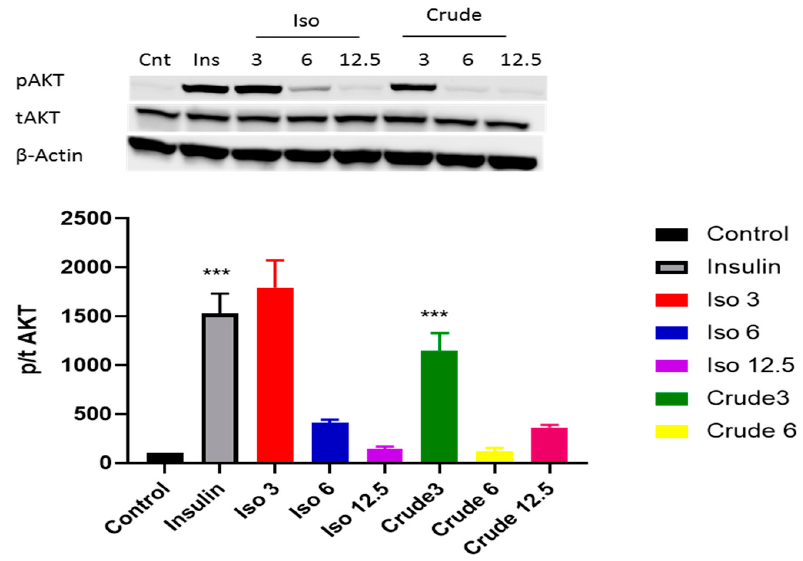
Figure 4. The effect of iso-mukaadial acetate and crude extract on protein kinase B (AKT) protein expression in L6 skeletal muscle cells. Results are expressed as mean ± SEM of three independent experiments., *** p < 0.001 versus, Iso 3: iso-mukaadial acetate 3 µg/mL, Iso 6: iso-mukaadial acetate 6 µg/mL, Iso 12: iso-mukaadial acetate 12.5 µg/mL, Crude 3: crude extract 3 µg/mL and Crude 6: crude extract 6 µg/mL.